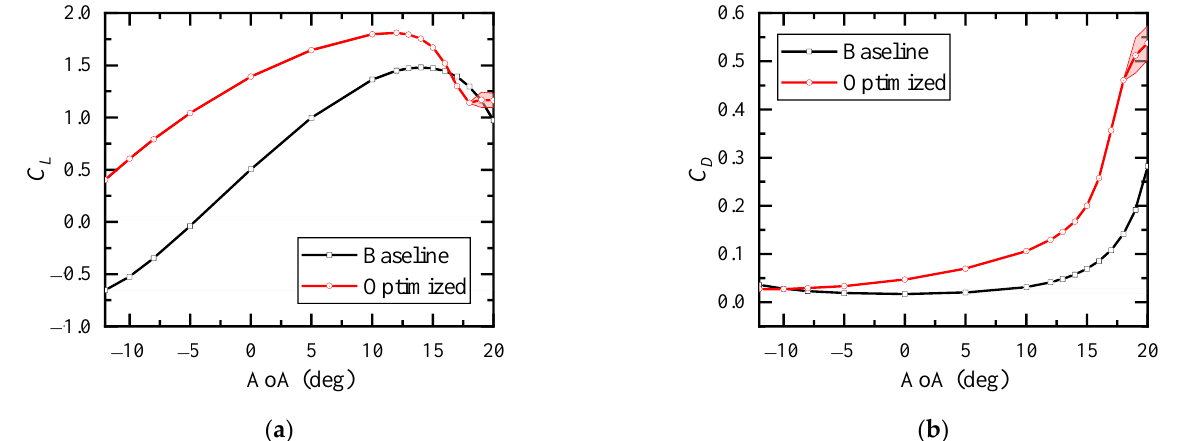
Figure 3. Comparison of the aerodynamic coefficient for the baseline and the optimized airfoil. ( a ) Lift coefficient. ( b ) Drag coefficient.